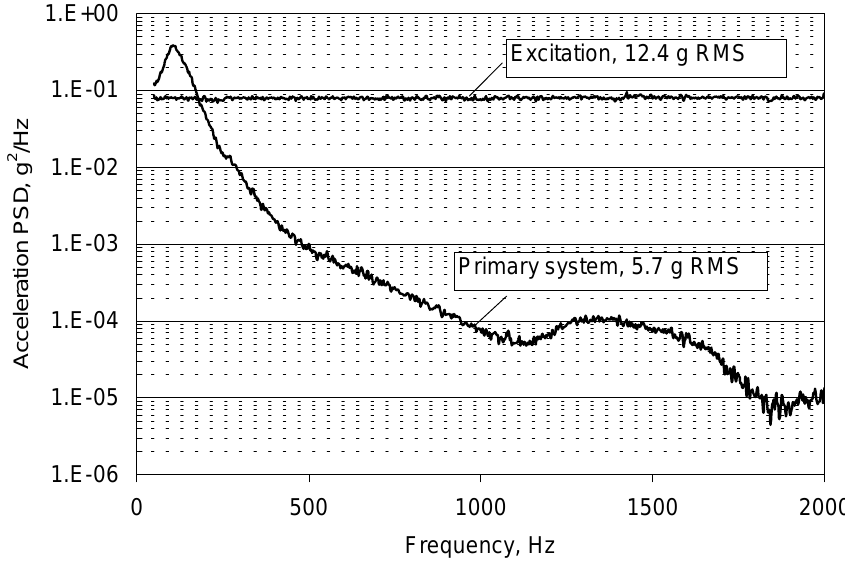
Fig. 17. Experimentally measured excitation and dynamic response of the primary vibration